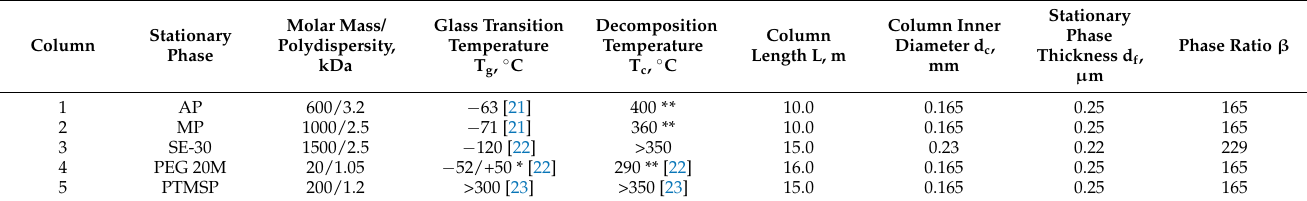
Table 1. Physical properties of GC columns and stationary phases used in the study.